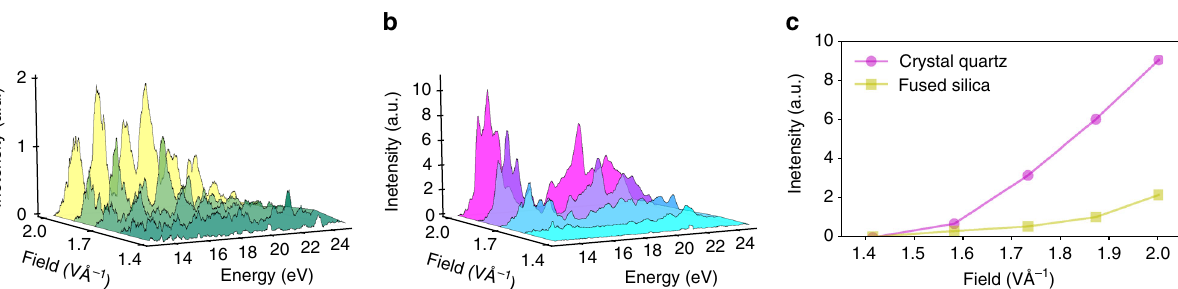
Fig. 2 Dependence of high-harmonic spectrum with the laser peak fi eld. Dependence of high-harmonic spectrum with the peak fi eld of the driving laser for a fused silica and b crystalline quartz. For crystalline quartz, the spectral minimum seen around 17 eV persists for different peak fi elds. c is the comparison of fused silica and quartz for their total yield (from ~14 to ~25 eV) with different peak fi elds. At modest fi elds the total yield is similar, but the intensity scaling is signi fi cantly different and eventually crystalline quartz becomes more ef fi cient